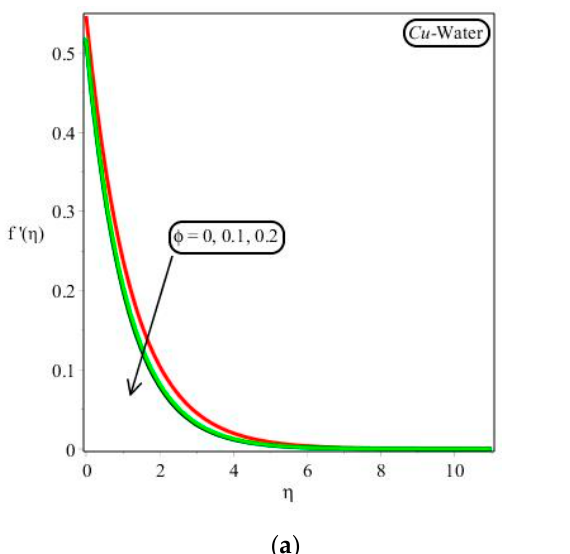
Figure 2. ( a , b ) Impact of K 1 on velocity profile with β = 1, γ = π /3, 𝜙 = 0.2, and M = 0.2.